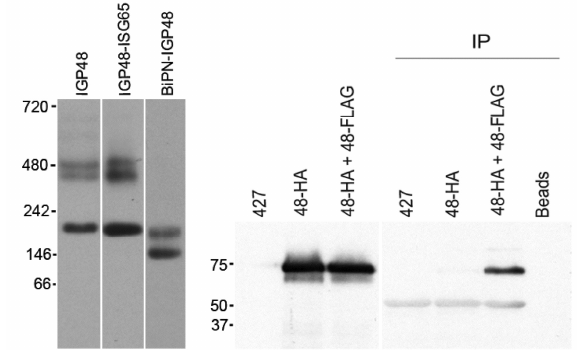
FIGURE 7: IGP48 forms a complex in vivo . Lysates from cells ex- pressing various IGP48 chimeras were subjected to native PAGE, followed by detection by Western blotting. Left: Replacement of the IGP48 ectodomain with the BiP ATPase domain (BiPN-IGP48) results in loss of the high molecular weight (450 – 500 kDa) com- plexes. Right: Cells expressing IGP48-HA or IGP48-HA (48-HA) plus IGP48-FLAG (48-FLAG) were immunoprecipitated with anti-FLAG antibody, followed by Western blotting with anti-HA antibody. Whole cell lysates are shown to the left, and wild-type (427) and single transfected cells, as well as a bead plus lysate with no anti- body IP control (Beads).